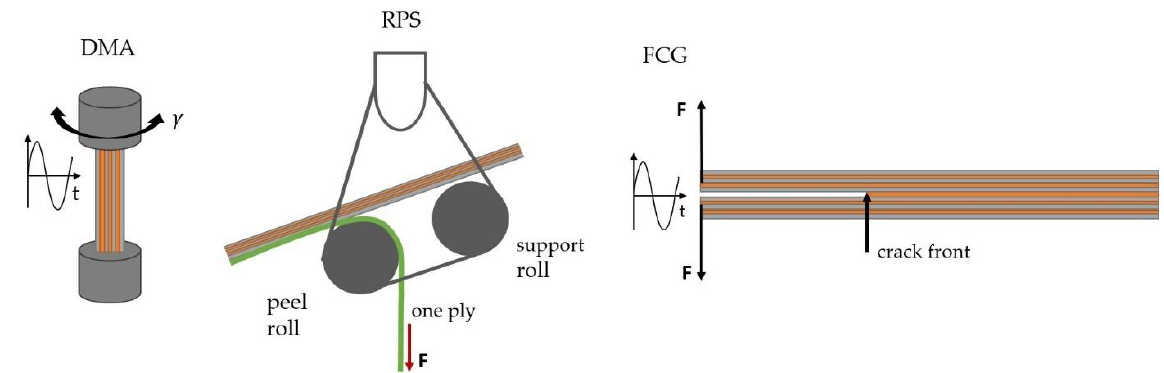
Figure 3. Schematic configurations of test setups for dynamic mechanical analysis (DMA, left ), monotonic roll peel strength testing (RPS, middle ) and fatigue crack growth assessment (FCG) using a double cantilever beam (DCB) specimen ( right ).